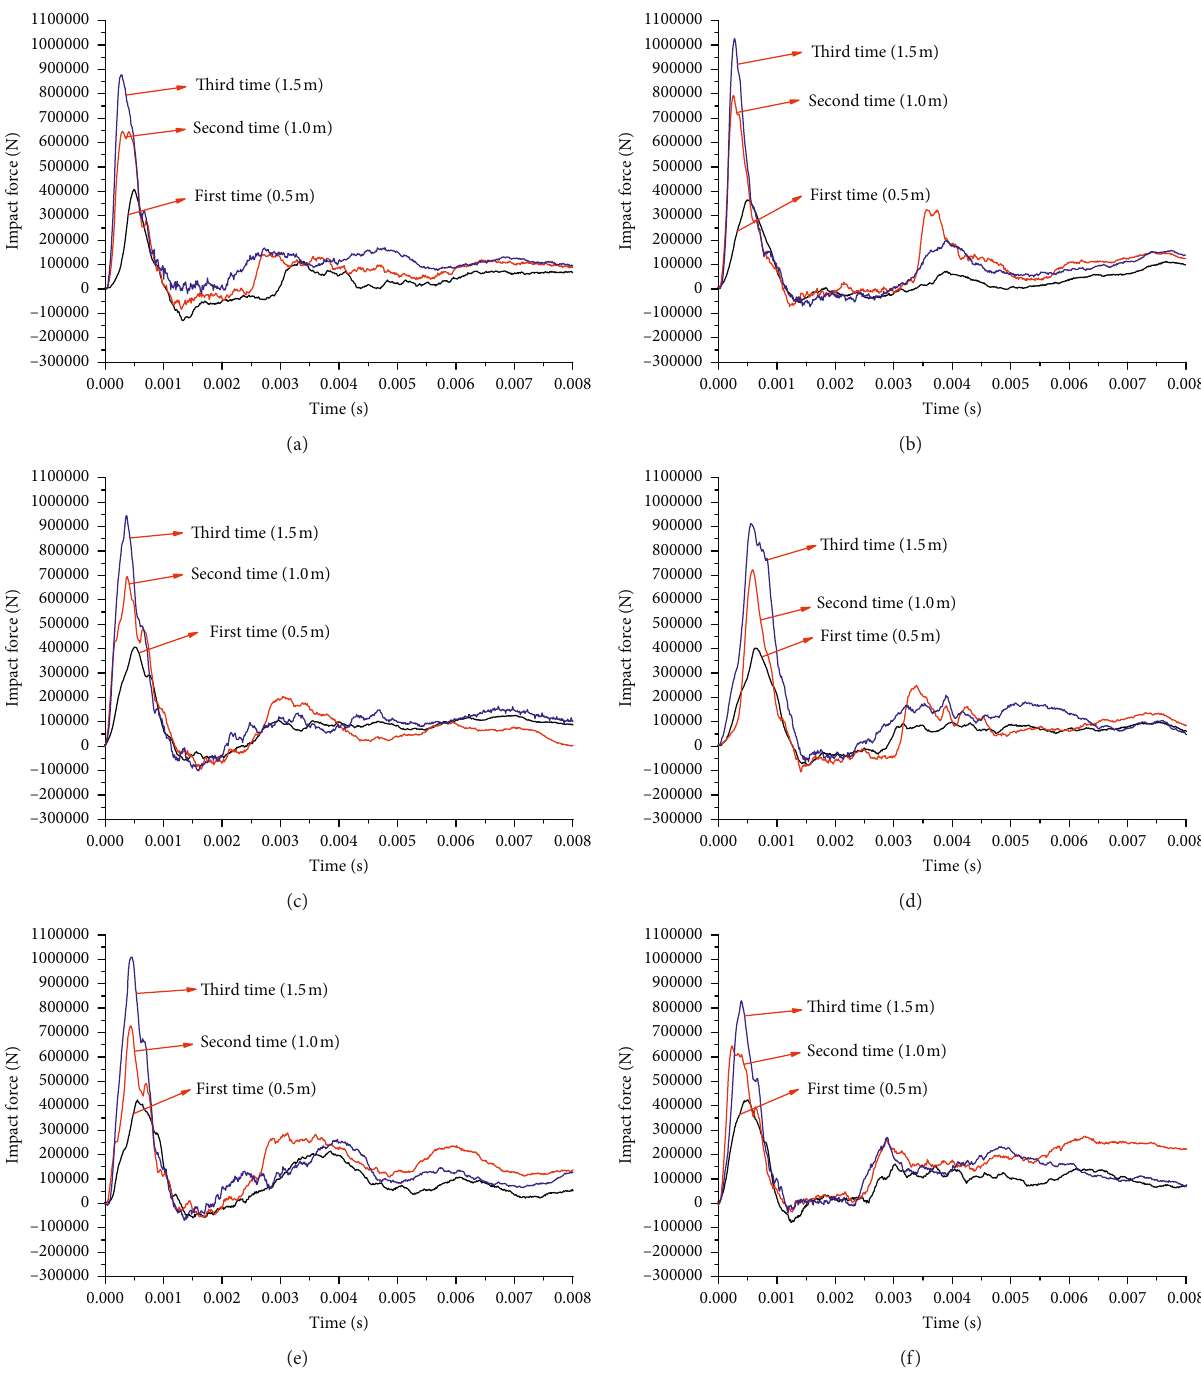
Figure 9: Time history curves of the impact forces. Group A: (a) L18 and (b) S12. Group B: (c) L20 and (d) S16. Group C: (e) L25 and (f)